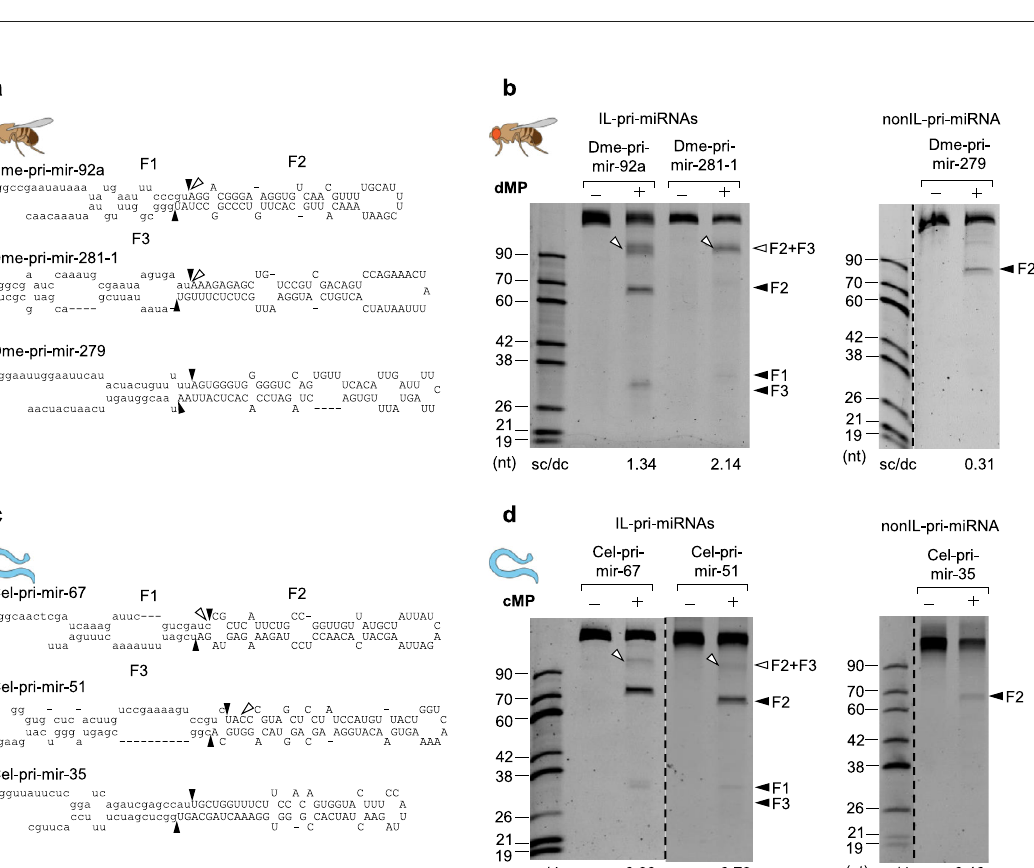
Fig. 1 The internal loop (IL) in the lower stem is a common feature of animal pri-miRNAs. a The domain composition of DROSHA in H. sapiens (humans), D. melanogaster , and C. elegans . P-rich, proline-rich; RS, arginine-serine-rich; CED, central domain; RIIIDa and RIIIDb, RNase III domains; and dsRBD, double- stranded RNA-binding domain. b The 10,895 pri-miRNA sequences were collected from MirGeneDB 2.0. The secondary structures of these pri-miRNAs were predicted using RNAfold. The IL was de fi ned as the internal loop containing more than 3 nt in the lower stem of pri-miRNAs. The green arrowheads represent the cleavage sites of DROSHA. c The percentage of IL-pri-miRNAs in 45 species (panel I). The ILs are usually located at 6 and 8 nt from the cleavage sites of DROSHA on the 5p-strand of pri-miRNAs (panel II). The major sizes of ILs are 2/2 (panel III). There are a total of 76 sizes of ILs found in all 45 species. The 8 main sizes of ILs were shown. The fraction values were colored according to the color bar (right). d The number of the similar IL-pri- miRNA orthologs (group A) and non-similar IL-pri-miRNA orthologs (group B) for each of 129 human IL-pri-miRNAs. e The average of sequence and structure entropies was estimated for the ILs, loops, and mature miRNA regions of the groups A and B. The error bars were drawn with 95% con fi dence intervals. f The sequence and structure entropies of the ILs of groups, A and B. The pri-miRNAs were classi fi ed into 4 groups, as shown in the fi gure. g The sequence and structure entropy pro fi les of hsa-pri-mir-92a-1 orthologs containing IL3/6 (the left panel) and hsa-pri-mir-92a-1 orthologs containing IL3/3 (the right panel). The entropy value for each position was colored according to the color bar (right). The green arrowheads represent the cleavage sites of DROSHA.